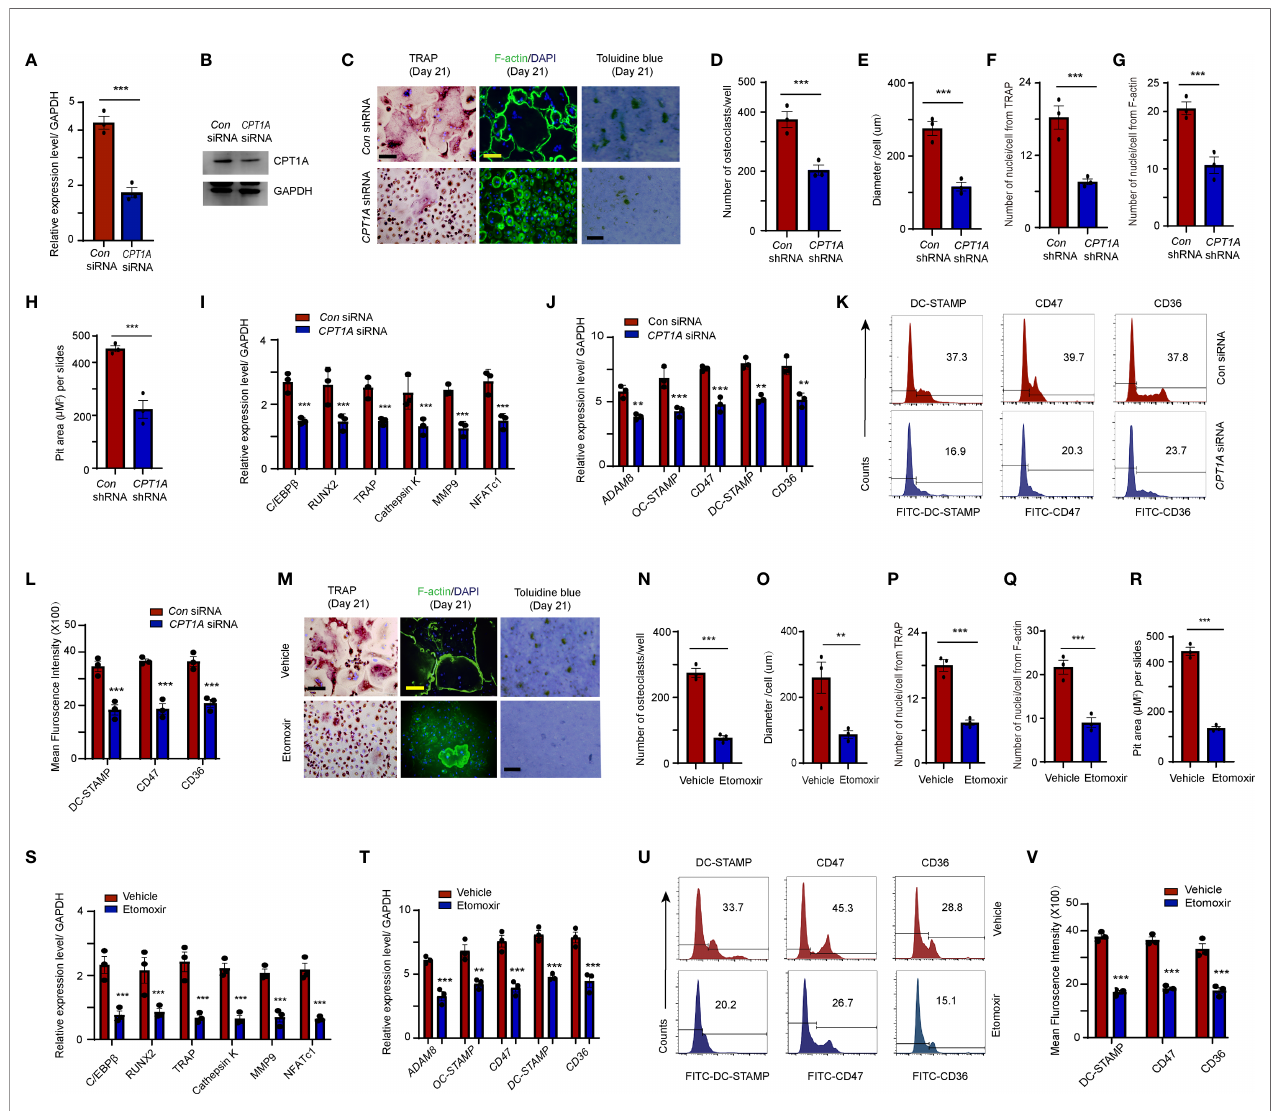
FIGURE 4 | Fusogenic molecule membrane accumulation in OCPs is regulated by CPT1A. (A – K) CD14 + monocytes isolated from RA patients were transfected with control and CPT1A -speci fi c siRNA or CPT1A shRNA after M-CSF and RANKL stimulation at day 2. (A, B) CPT1A siRNA. (A) CPT1A transcript levels were quanti fi ed by qPCR 24 h after control and CPT1A siRNA transfection. (B) Representative blotting for CPT1A expression. (C – G) Osteoclast differentiation. CD14 + monocytes from RA patients were transfected with short hairpin RNA expression lentivirus for CPT1A knockdown (pLV-mCherry-U6> CPT1A _shRNA) or with (pLV-mCherry-U6 >Scramble_shRNA) as a control. (C) Mature osteoclasts were detected by TRAP, bar 100 m m; and FITC – phalloidin staining on day 21. bar 100 m m. Bone resorption activity of osteoclasts was detected by toluidine blue staining on day 21. bar 50 m m . (D) Cell counts of mature osteoclasts from 24-well plates. (E) Mean diameter of mature osteoclasts. (F) Mean nuclei number of multinucleated TRAP-positive cells. (G) Mean nuclei number of multinucleated F-actin positive cells. (H) Pit area of bone resorption lacunae. Results from 3 RA patients are shown. (I) Transcript levels of C/EBP b , RUNX2 , TRAP , Cathepsin K , MMP9 , and NFATc1 were quanti fi ed by qPCR. (J) Transcript levels of fusogenic molecule expression were quanti fi ed by qPCR. (K) DC-STAMP, CD47, and CD36 membrane expression were analyzed by fl ow cytometry. Representative histograms for one control siRNA (blue) and one CPT1A siRNA (red); three independent experiments from 3 RA are shown at (L) . (M – V) CPT1A inhibitor. RA-derived monocytes were treated with control or 25 m M etomoxir after M-CSF and RANKL stimulation. (M – R) Mature osteoclasts were detected by TRAP, bar 100 m m; and FITC – phalloidin staining on day 21, bar 100 m m. Bone resorption activity of osteoclasts was detected by toluidine blue staining on day 21. bar 50 m m. (N) Cell counts of mature osteoclasts from 24-well plates. (O) Mean diameter of mature osteoclast. (P) Mean nuclei number of multinucleated TRAP-positive cells. (Q) Mean nuclei number of multinucleated F-actin positive cells. (R) Pit area of bone resorption lacunae. Results from 3 RA patients are shown. (S) Transcript levels of C/EBP b , RUNX2 , TRAP , Cathepsin K , MMP9 , and NFATc1 were quanti fi ed by qPCR. (T ) Transcript levels of fusogenic molecule were quanti fi ed by qPCR. (U) The DC-STAMP, CD47, and CD36 membrane expression in monocytes were analyzed by fl ow cytometry Representative histograms for one control (blue) and one etomoxir (red); three independent experiments examining 3 RA are shown at (V) . All data was presented as the mean ± SEM. ** P < 0.01; *** P <